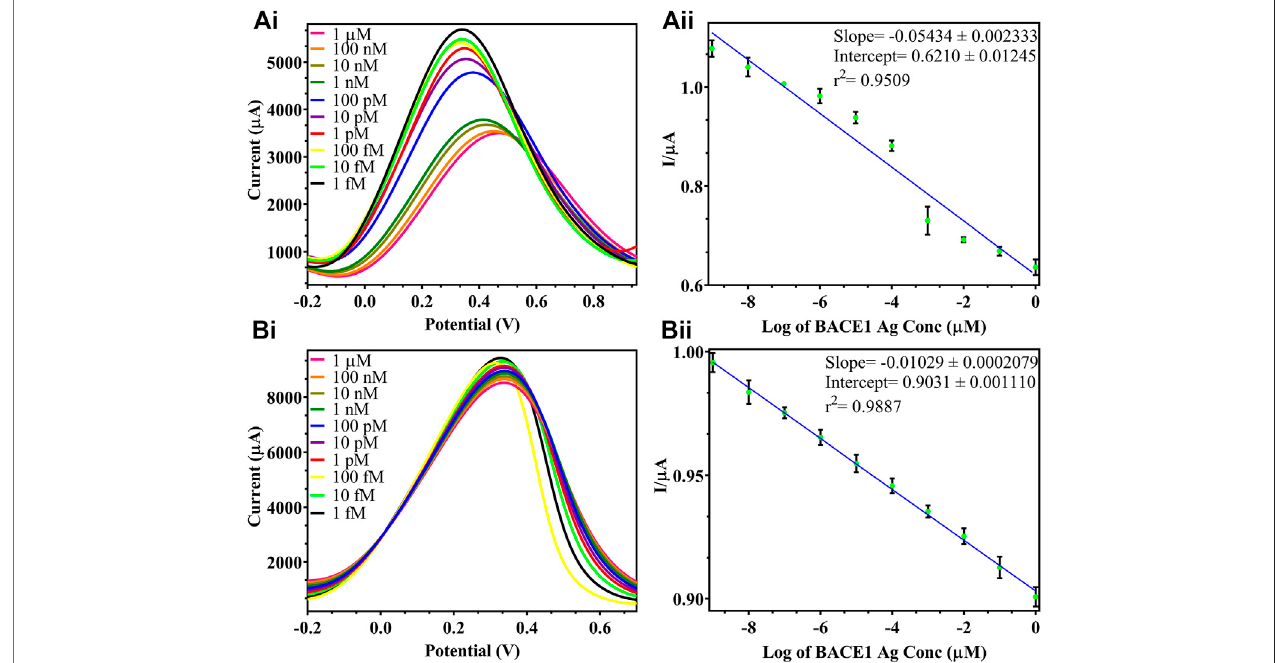
FIGURE 5 | DPV of varying BACE 1 Ag concentrations in buffer samples: (Ai) . testing of varying BACE1 Ag concentrations ranging from 1 μ M to 1fM at 10-fold dilutions; (Aii) .standardcalibrationgraphoflogofBACE1Agconcentrationsinbuffervs.I/ μ A=peakcurrent/blankcurrent;DPVofvaryingBACE1Agconcentrationsin spiked serum samples: (Bi) . testing ofvaryingBACE1 Agconcentrations ranging from 1 μ M to1fM at 10-fold dilutions; (Bii) .standard calibration graphof logofBACE1 Ag concentrations in serum vs. I/ μ A = peak current/blank current.